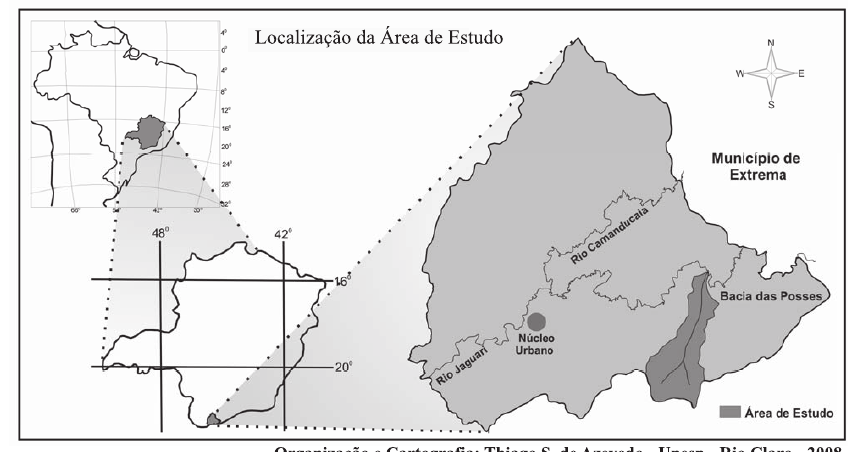
Figura 1. Localização geográfica da sub-bacia das Posses. Fonte: Azevedo